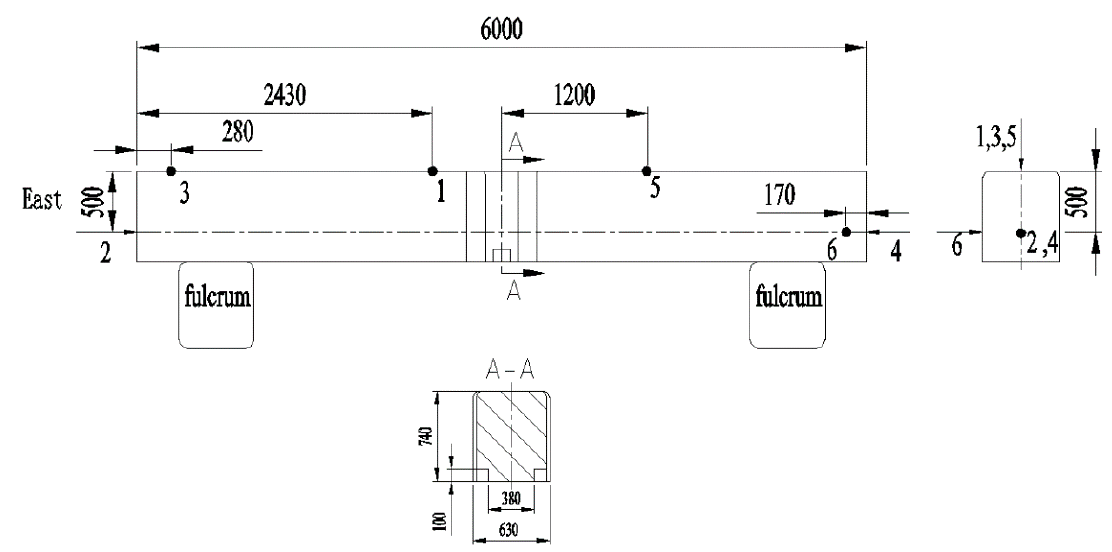
Figure 6. Diagram of the ridge beam marked with testing points 1–6.